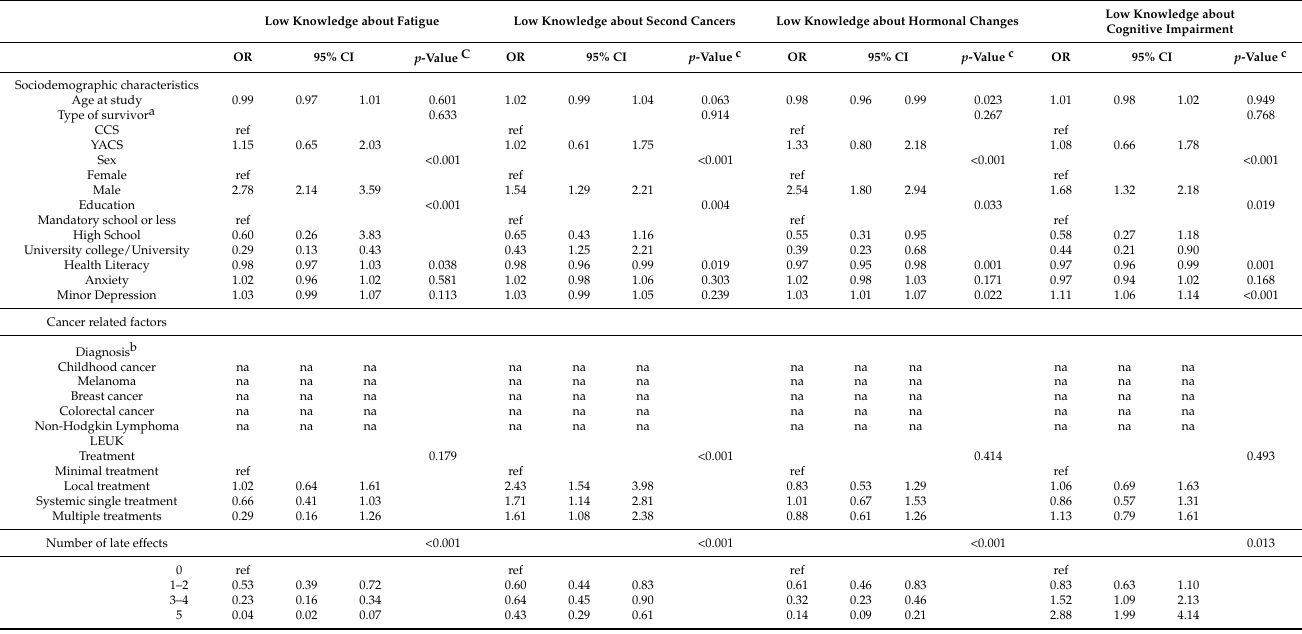
Table 4. Factors associated with low knowledge about different late effects from multivariable logistic regression models (n =